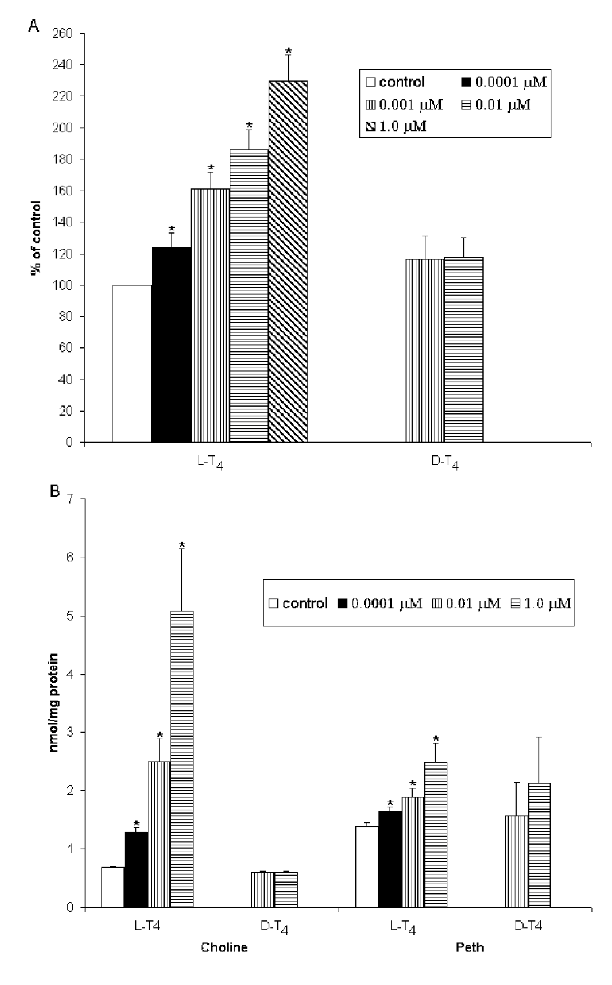
Figure 2 Dose-dependent action of thyroid hormone on DAG (A), choline and Peth (B) formation in